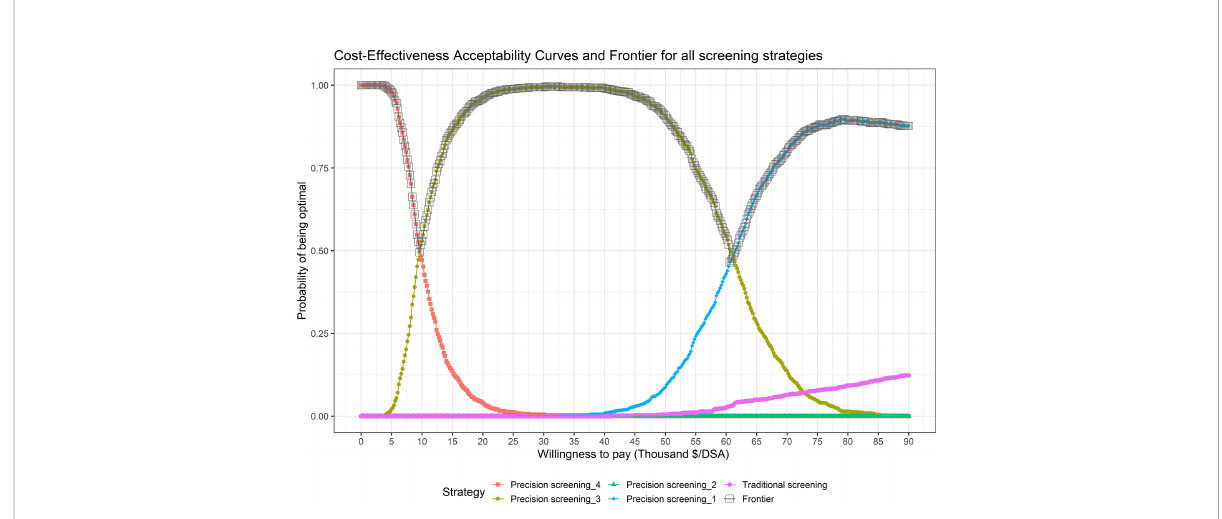
Strategy Baseline enrollment